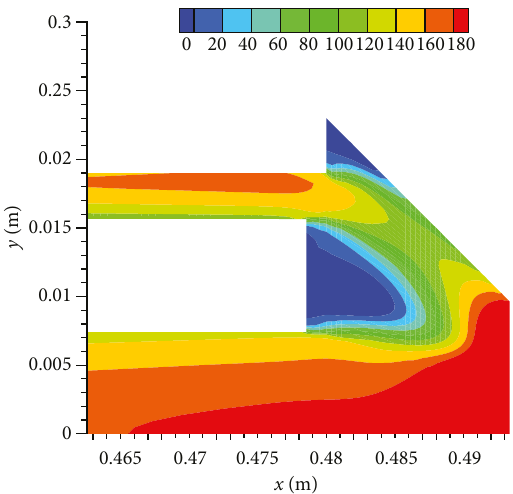
Figure 2: Axial velocity contour near the aft-end section of the